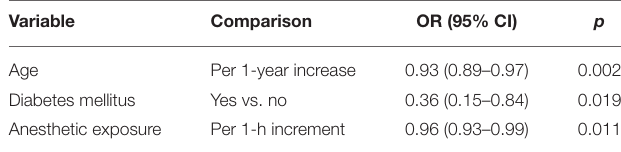
TABLE 4 | Associations between clinical variables and 90-days survival on stepwise backward Wald logistic regression